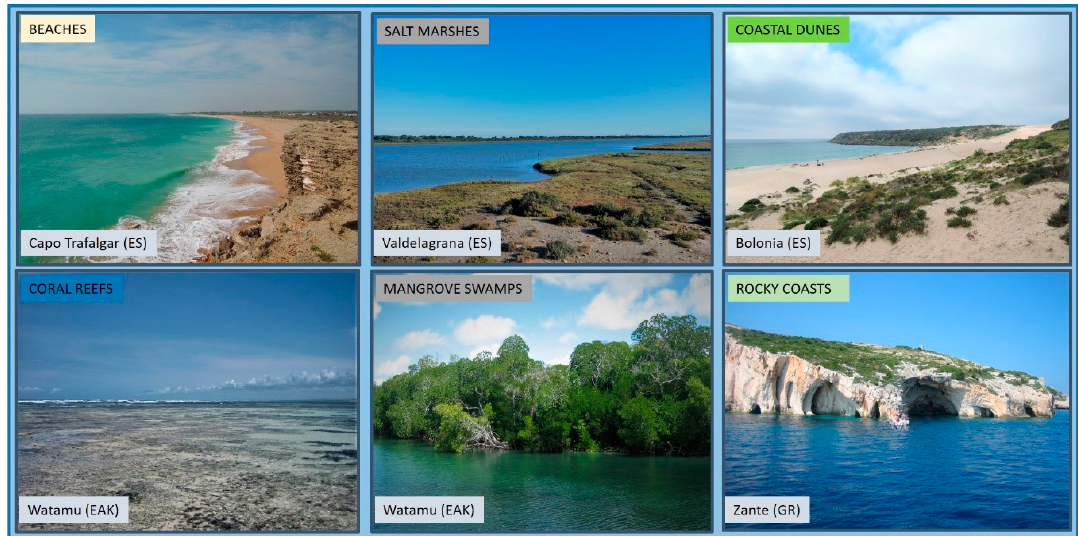
Figure 1. Examples of common coastal landforms. Source: authors.